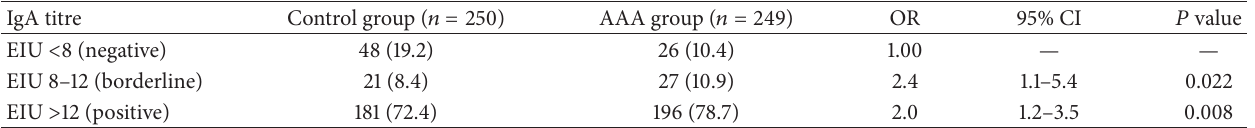
Table 3: Comparison of control and AAA groups based on IgA antichlamydial antibody titres. 𝜒 2 = 7.89 , df = 2, and 𝑃 = 0.019 . The numbers in parenthesis represent percentage.